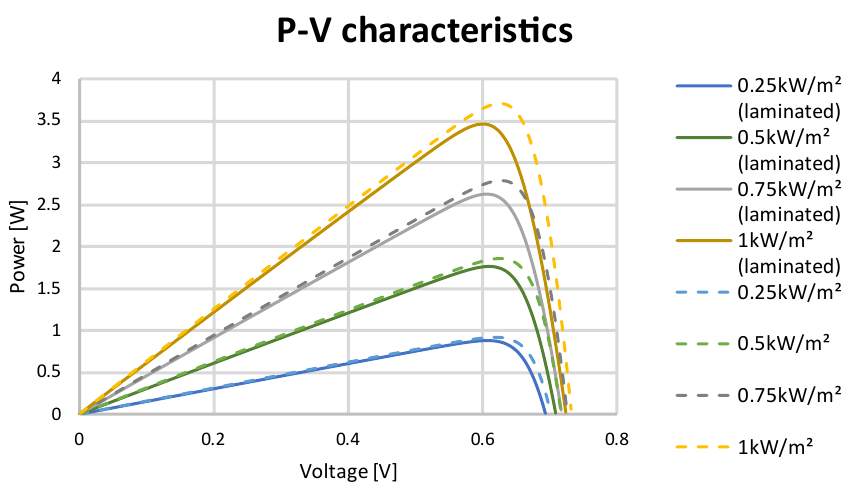
Figure 11. P–V curve at different irradiation levels for SunPower Maxeon Ne3 cells. Figure 11. P – V curve at different irradiation levels for SunPower Maxeon Ne3 cells. Table 5. MPPT data of tested solar cell.